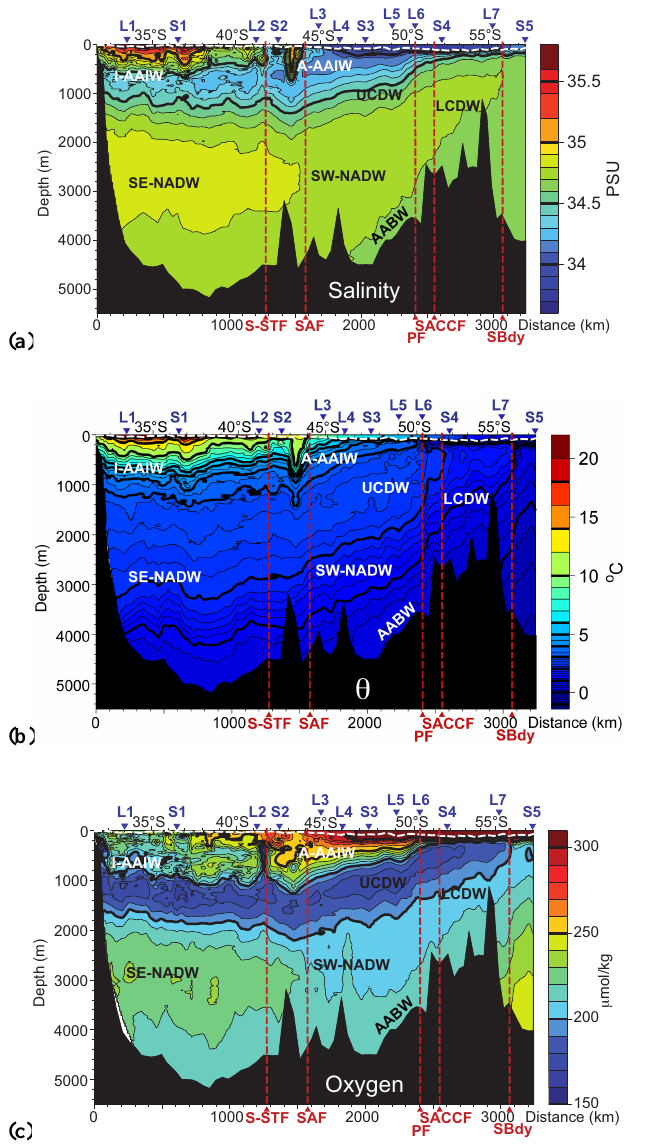
Fig. 2. Vertical distribution of salinity (a) , theta (b) , and oxygen (c) measured along the transect from the north (left) to the south (right) of the section. Water masses are indicated: AAIW: Antarc- tic Intermediate Water. This water mass is coming from the Indian Ocean through the Agulhas Current (I-AAIW) north of ∼ 37 ◦ S and from the Atlantic sector (A-AAIW) south of 37 ◦ S (Gordon et al., 1992). NADW: North Atlantic Deep Water. The highest salin- ity values close to the African continental slope reflect advection by a southeastward deep boundary current (SE-NADW, Arhan et al., 2003). LCDW: Lower Circumpolar Deep Water and AABW: Antarctic Bottom Water.